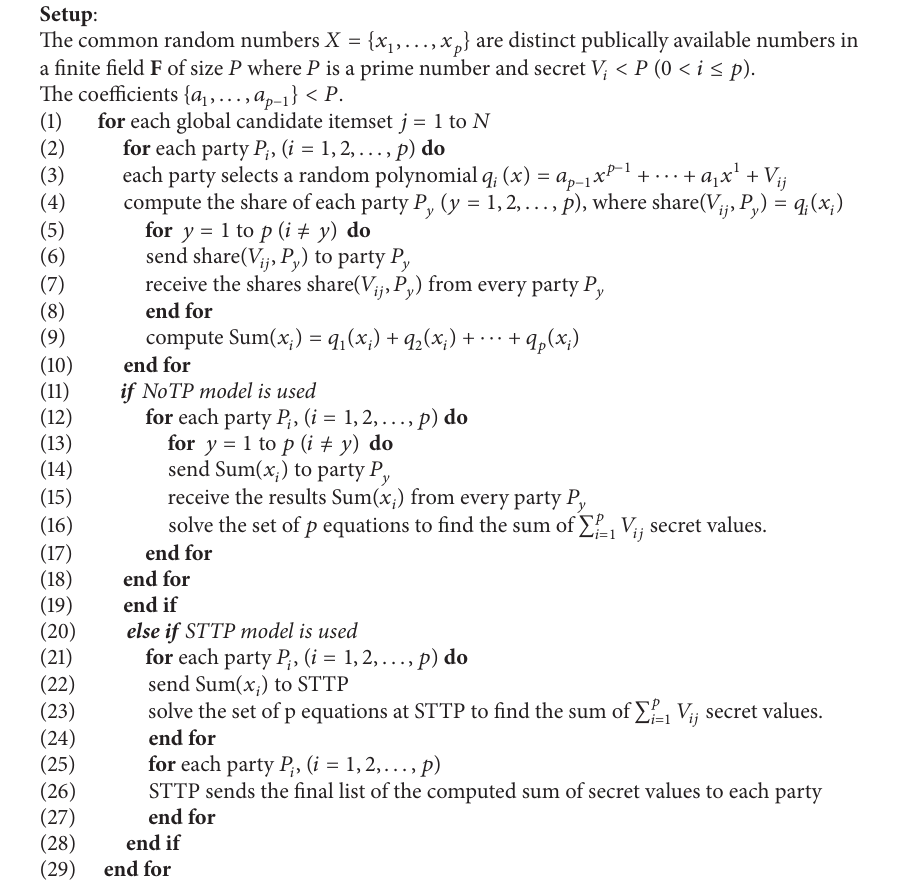
Algorithm 1: Proposed algorithm for PPDFIM using Shamir’s secret sharing based on NoTP model and STTP